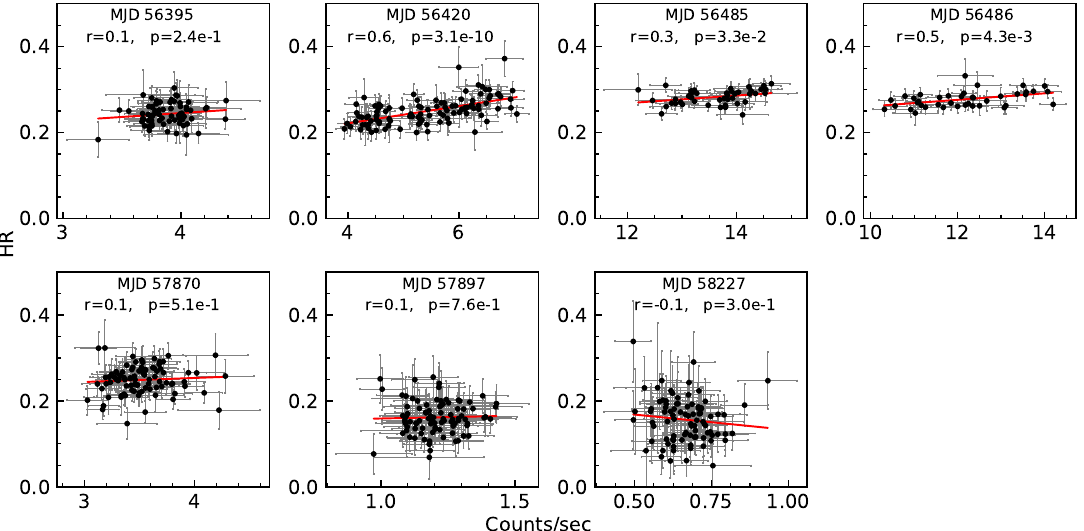
Figure 2. The variation of hardness ratio (HR) with respect to 3–79 keV flux (in the units of count rates). The MJD of observation, correlation coefficient (r), and the null hypothesis probability (p) are given in each